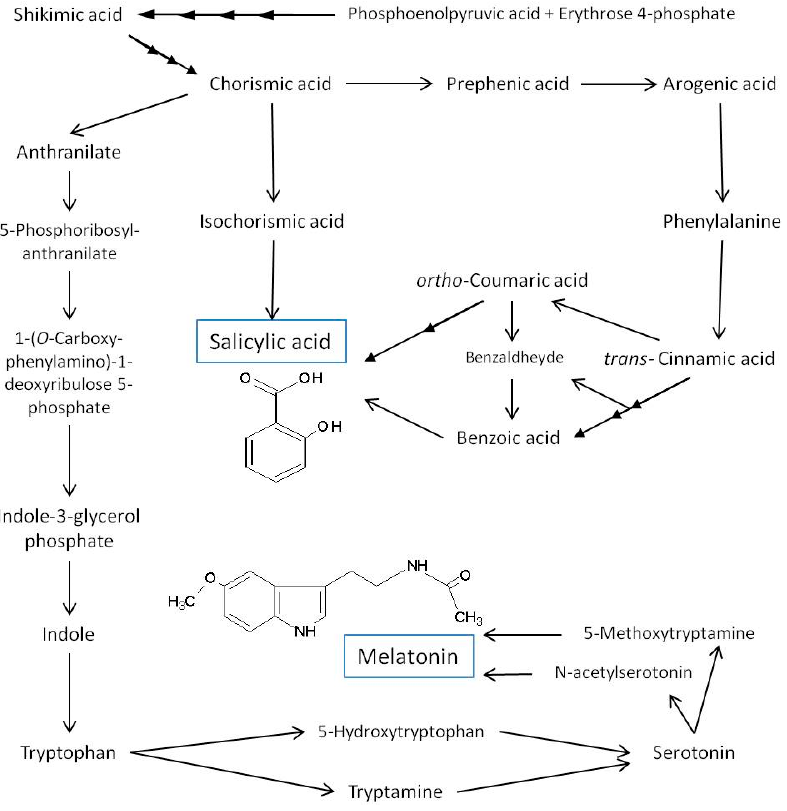
Figure 1. Biosynthetic routes of salicylic acid and melatonin in plants.